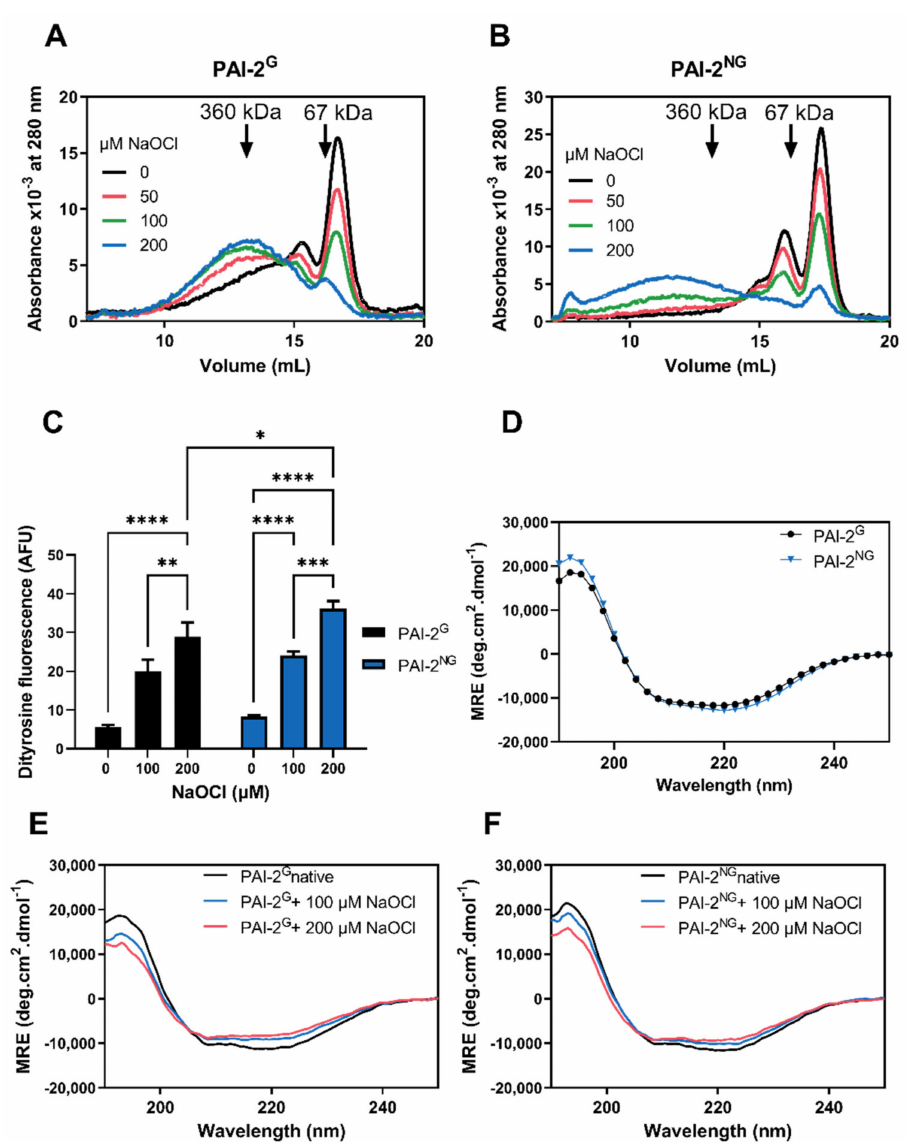
Figure 1. Biochemical analyses showing the effect of hypochlorite on PAI-2 G and PAI-2 NG . Size exclusion chromatography showing hypochlorite-induced oligomerisation of ( A ) PAI-2 G and ( B ) PAI- 2 NG . Arrows depict elution of molecular weight standards pregnancy zone protein (360 kDa) and bovine serum albumin (67 kDa). ( C ) PAI-2 G or PAI-2 NG pre-treated with 0–200 µ M hypochlorite were analysed for intrinsic fluorescence (AFU; excitation = 325 nm, emission = 420 nm). Data are means ± SD ( n = 3) and are representative of three independent experiments. One-way ANOVA with post-hoc Tukey’s HSD was used to identify non-significant (ns) and significant differences within the PAI-2 forms compared to untreated controls (**** = p < 0.0001; *** = p < 0.001; ** = p < 0.01; * = p < 0.05). There were no significant differences between untreated and treated PAI-2 G or PAI-2 NG except for the 200 µ M treatment; * p = 0.037. ( D ) CD spectroscopy displayed as mean residue ellipticity (MRE) of PAI-2 G and PAI-2 NG measured between 190 and 250 nm at 24 ◦ C under native conditions or following 0–200 µ M hypochlorite pre-treatment of ( E ) PAI-2 G or ( F ) PAI-2 NG